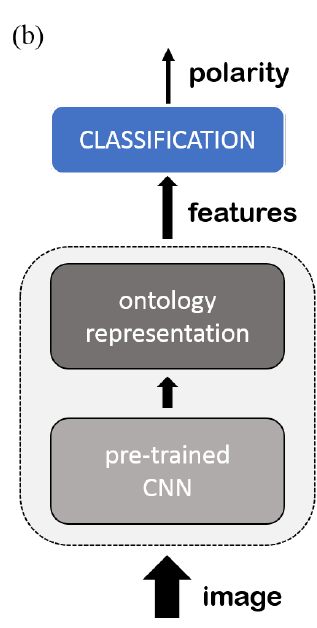
Figure 4. Designs of polarity detection frameworks. ( a ) The low-level features provided by the pre-trained CNN feed a classifier entitled to tackle polarity detection. ( b ) The low-level features provided by the pre-trained CNN feed a module entitled to model an ontology; such mid-level representation feeds the classifier entitled to tackle polarity